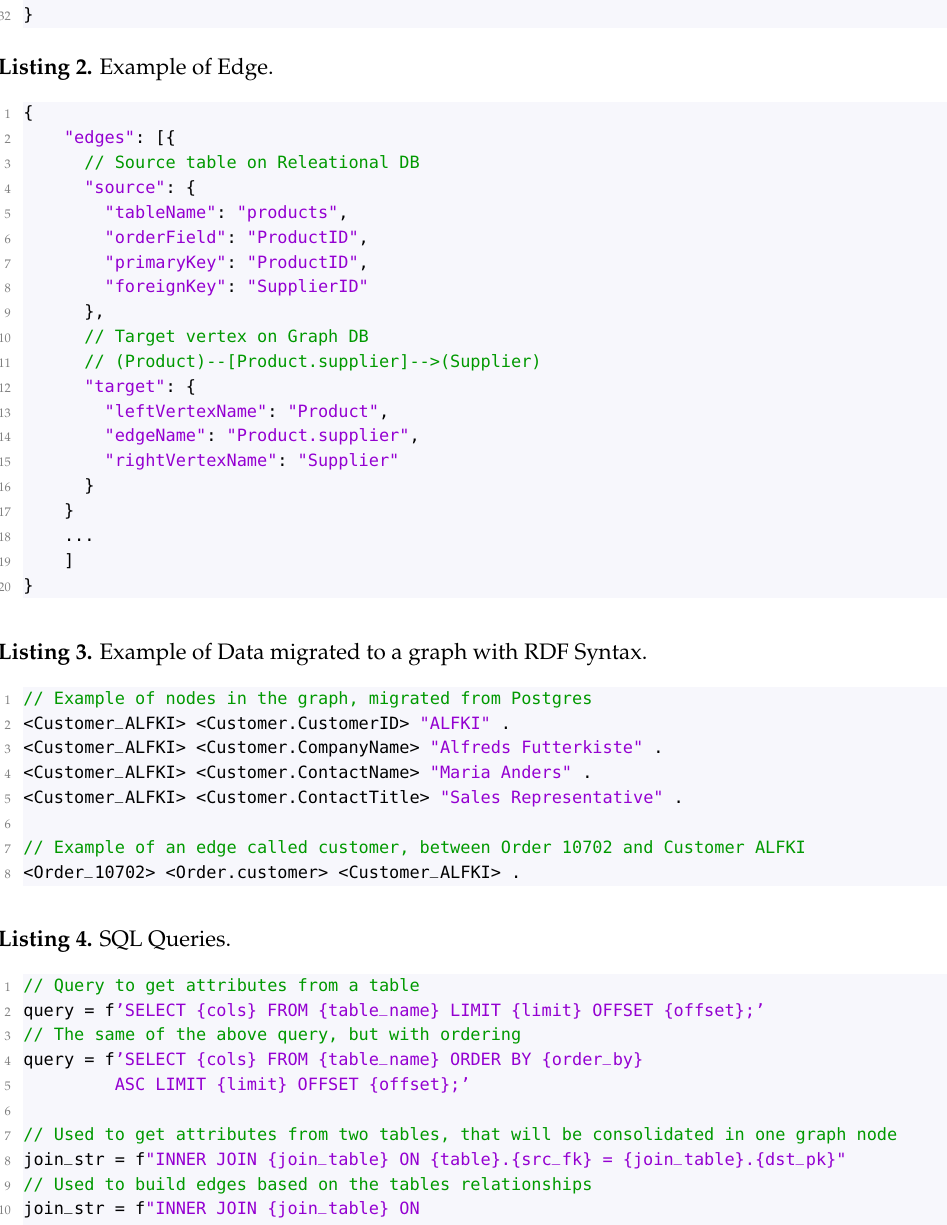
{table}.{join[’src_fk’]} =